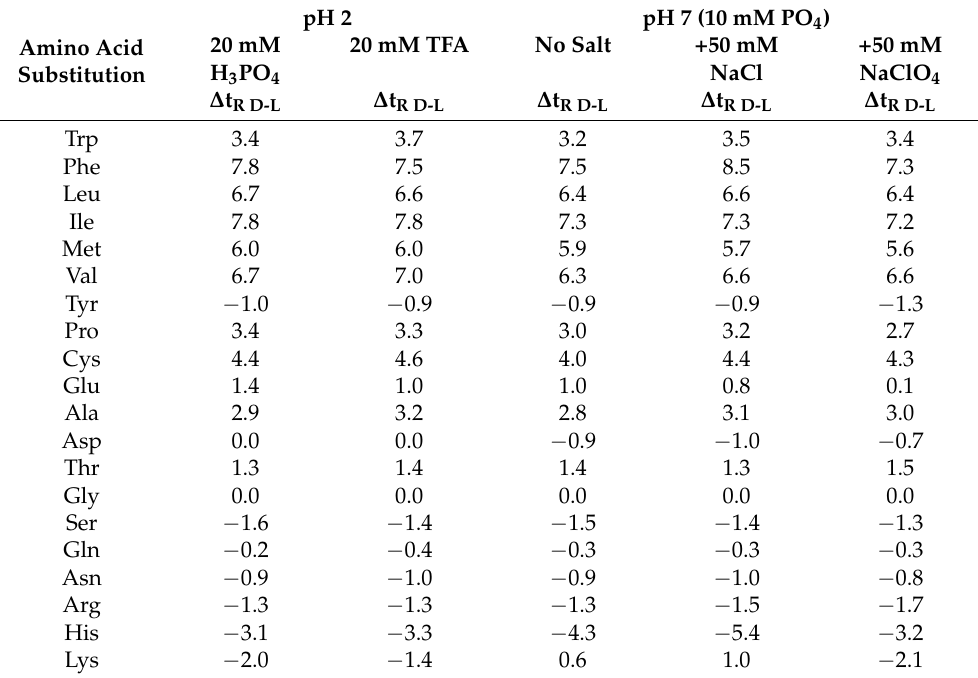
Table 11. Retention times differences in mobile phases (presence of nearest neighbour effect)